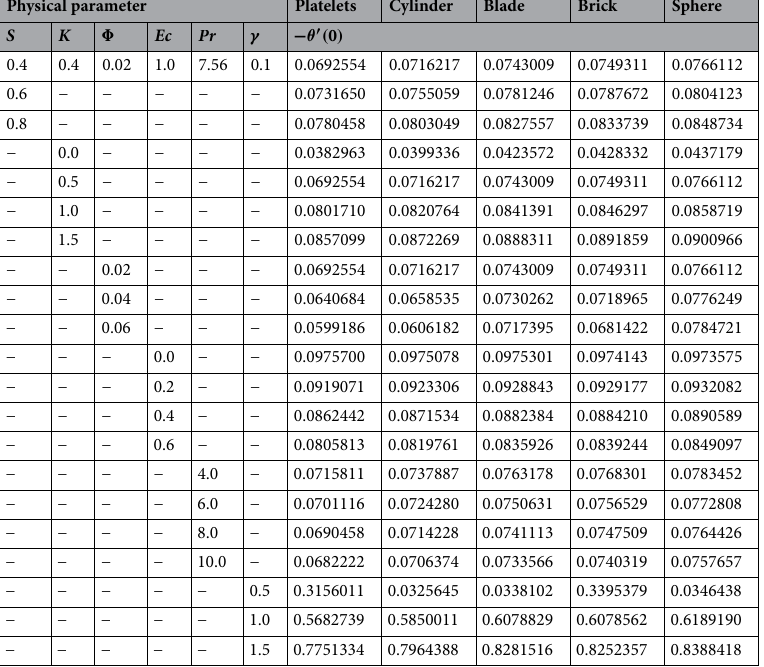
θ ′ ( 0 ) for multi-shape −